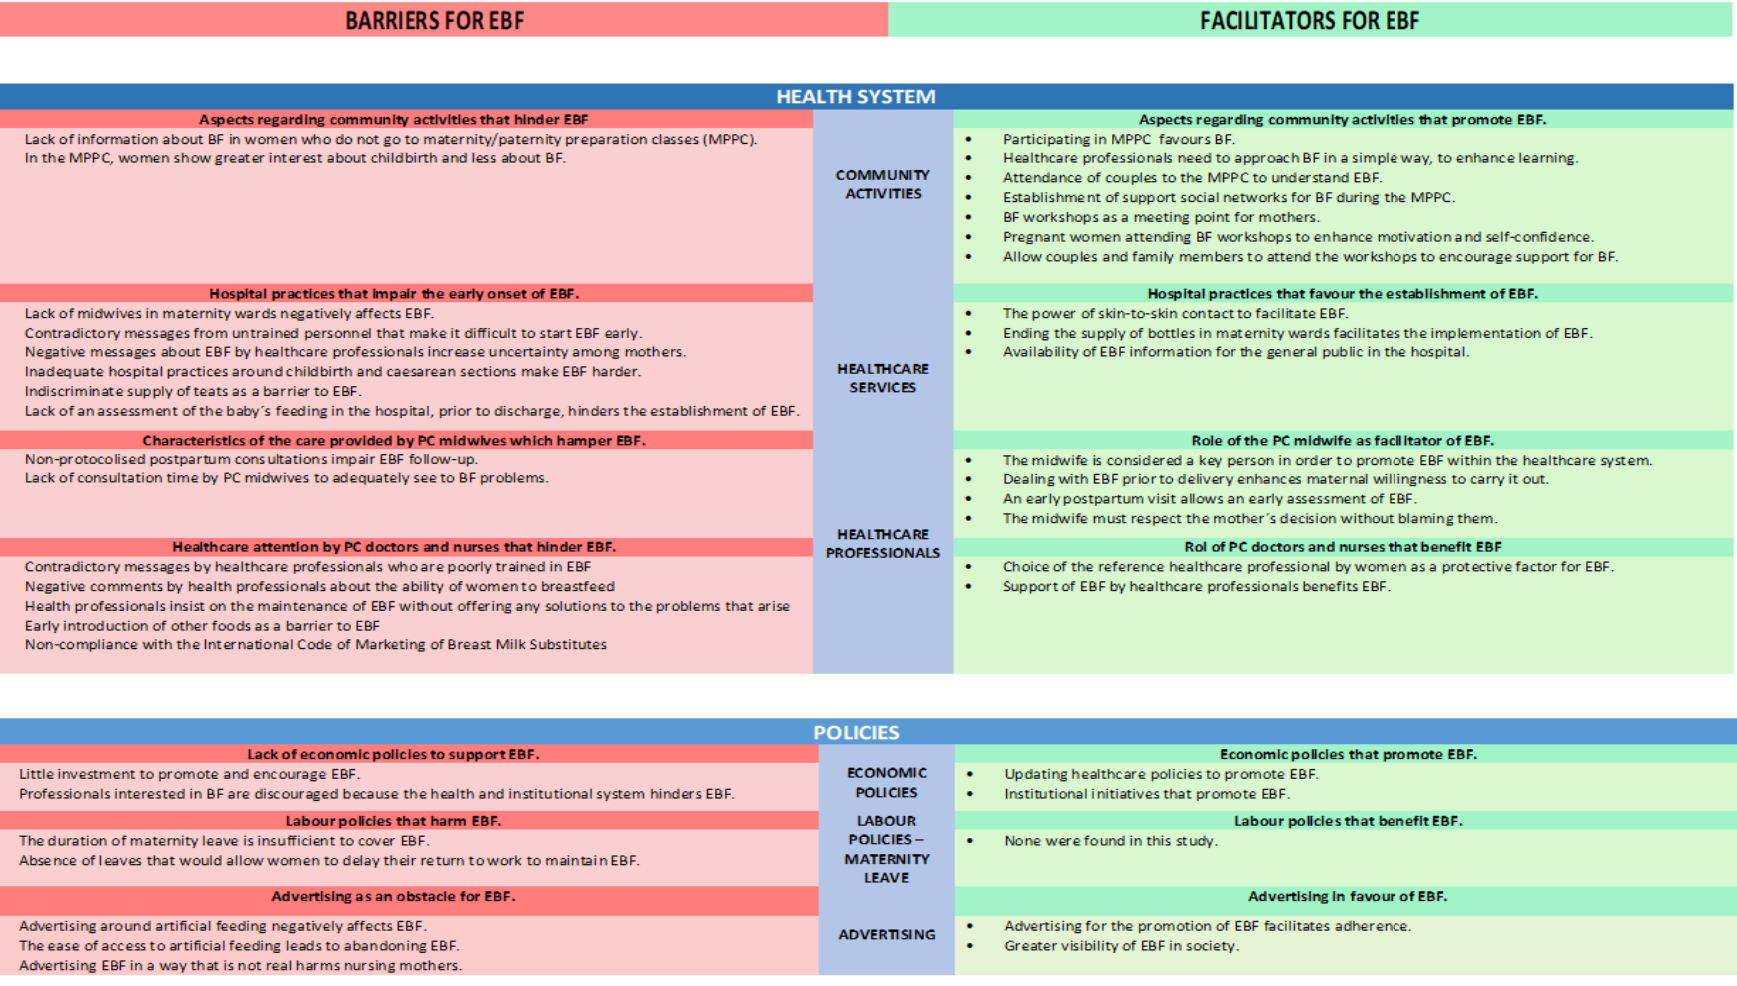
Figure 2. Facilitators and barriers for EBF within the health system and public policies according to Primary Care midwife´s perspectives in Tenerife (Canary Islands, Spain).